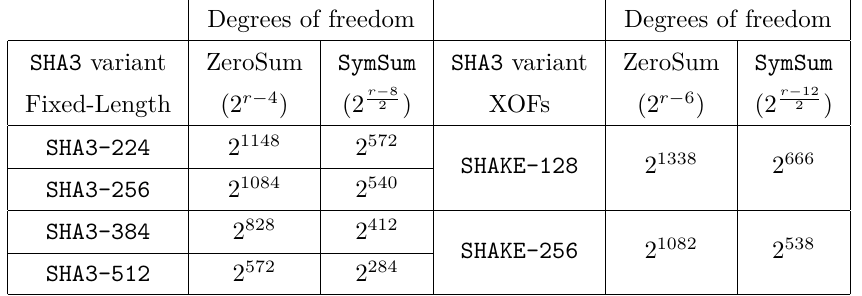
Table 3: Comparison of degrees of freedom of classical ZeroSum and SymSum for SHA3 fixed-length and XOF